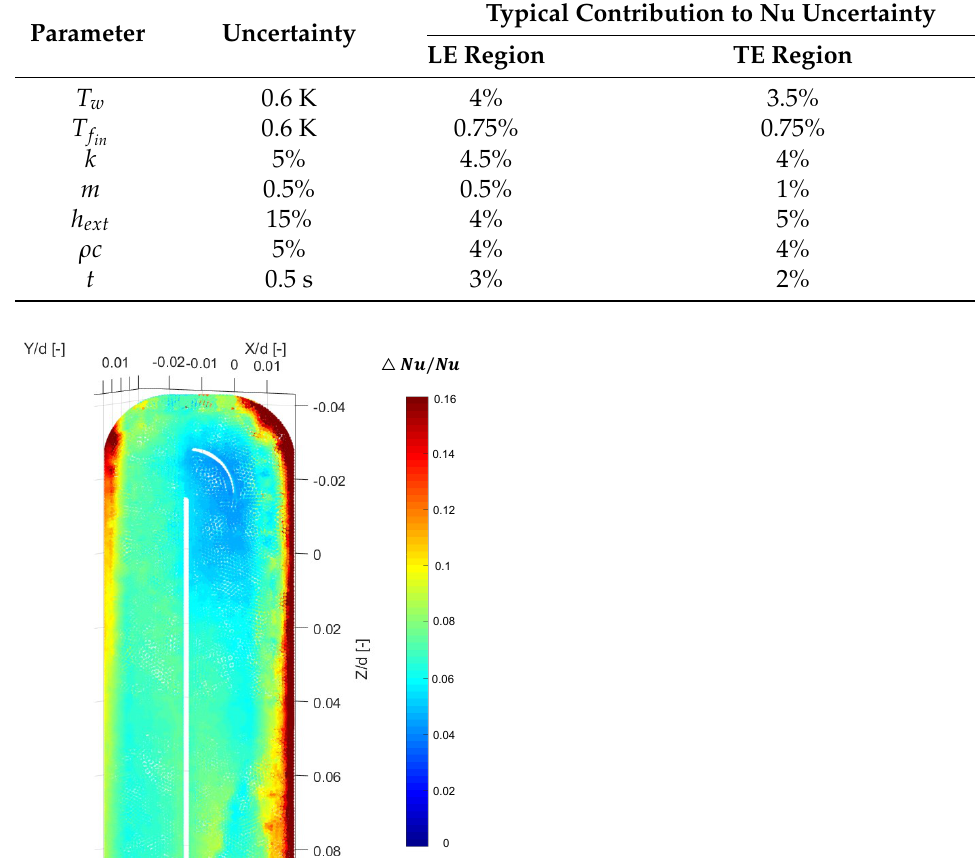
Figure 8. Local uncertainty for Re =